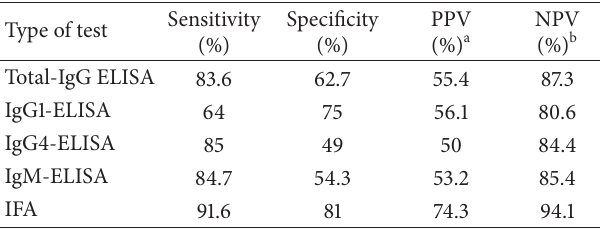
Table 1: Performance of different ELISA and IFA in diagnosis of cutaneous